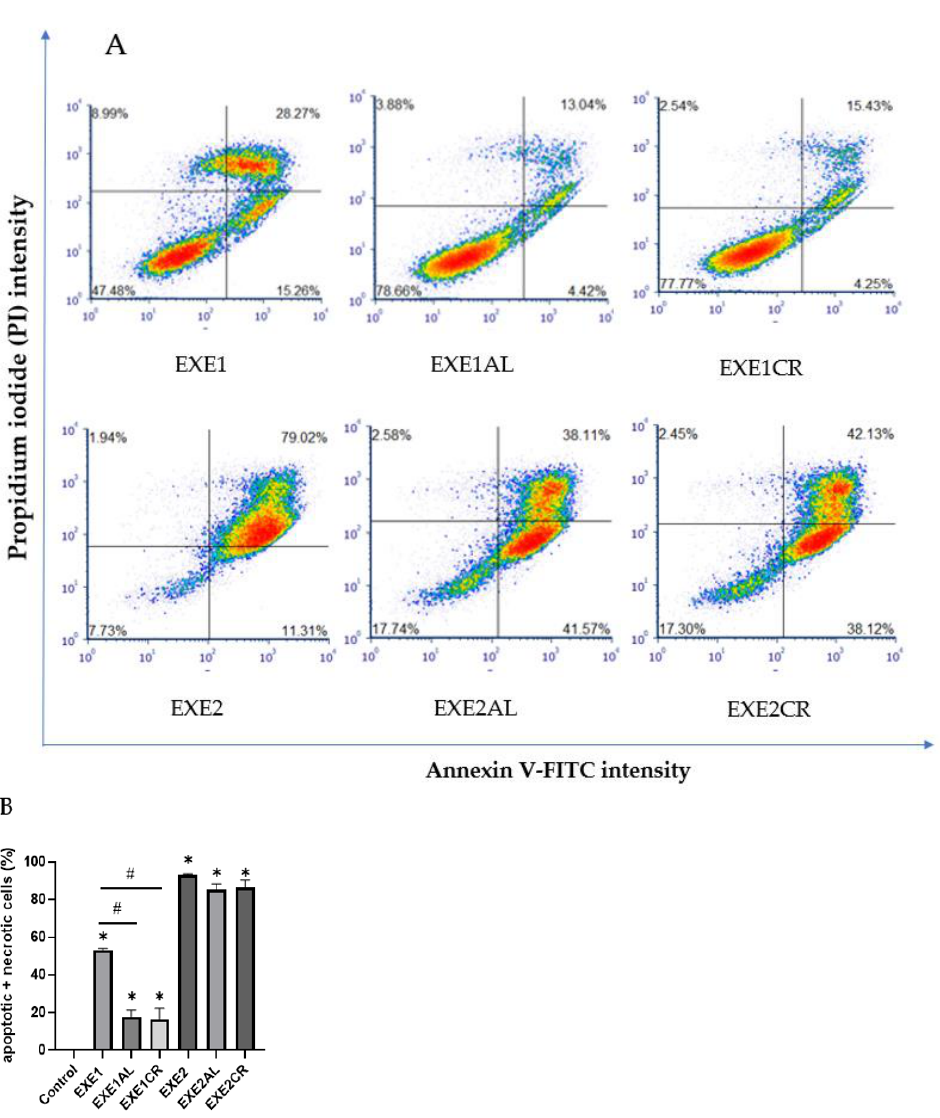
Figure 4. Effect of exemestane alone and in combination with metalloestrogens on MCF-7/DOX cell death. ( A ) Representative cytograms of flow cytometric are shown. EXE1 = 100 µM; EXE2 = 200 µM; Al./Cr(III) = 100 µM. ( B ) Percentage of both apoptotic (early and late apoptotic) and necrotic cells. The results are presented as mean ± SD, n = 3; p < 0.05; * statistically significant difference from control; # statistically significant difference from aromatase inhibitor alone.